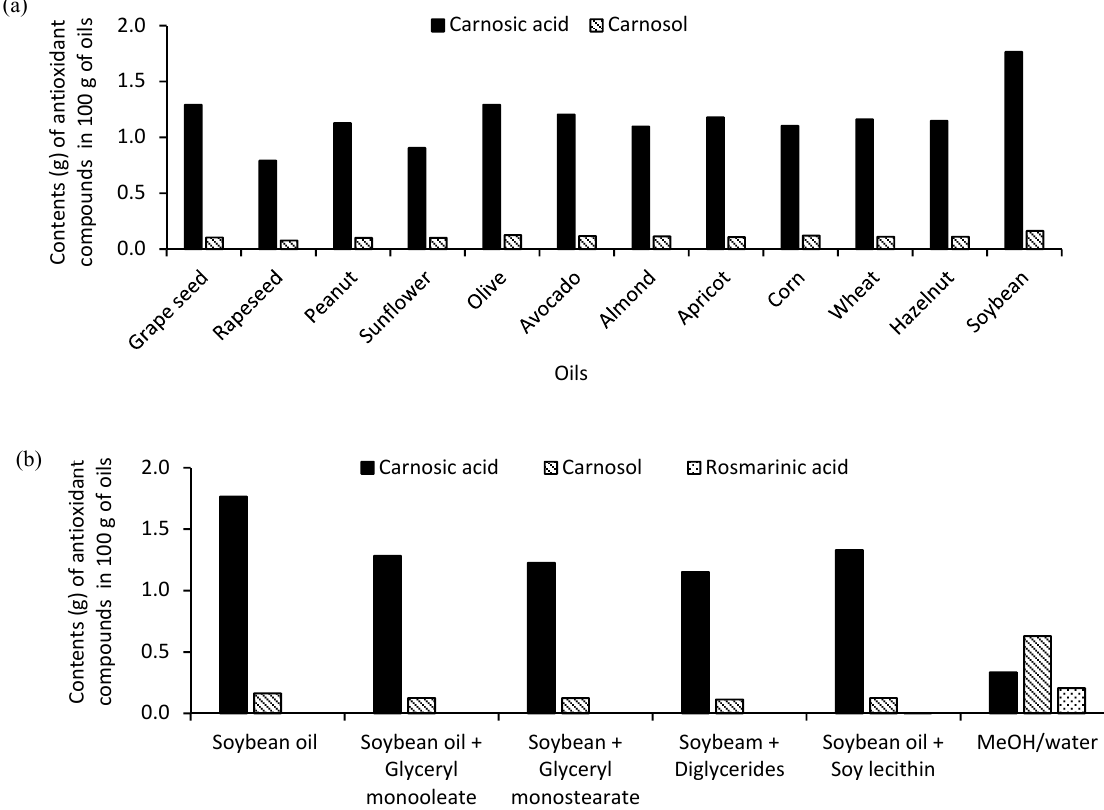
Figure 4. Content of carnosol and of carnosic and rosmarinic acids in rosemary oleo-extracts as determined by HPLC using ( a ) refined vegetable oils and ( b ) refined soybean oil with the addition of oil derivatives as solvents.